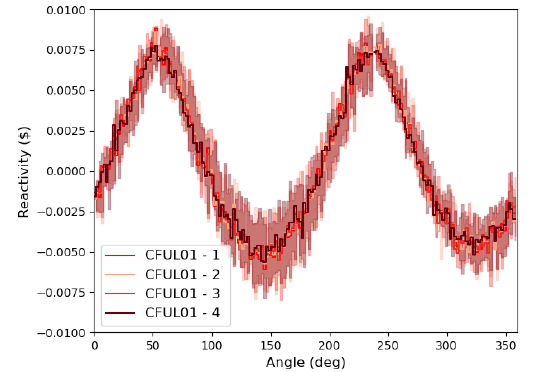
Figure 8. Measured reactivity profile of PISTIL with respect to its angular position from the dynamic calibration